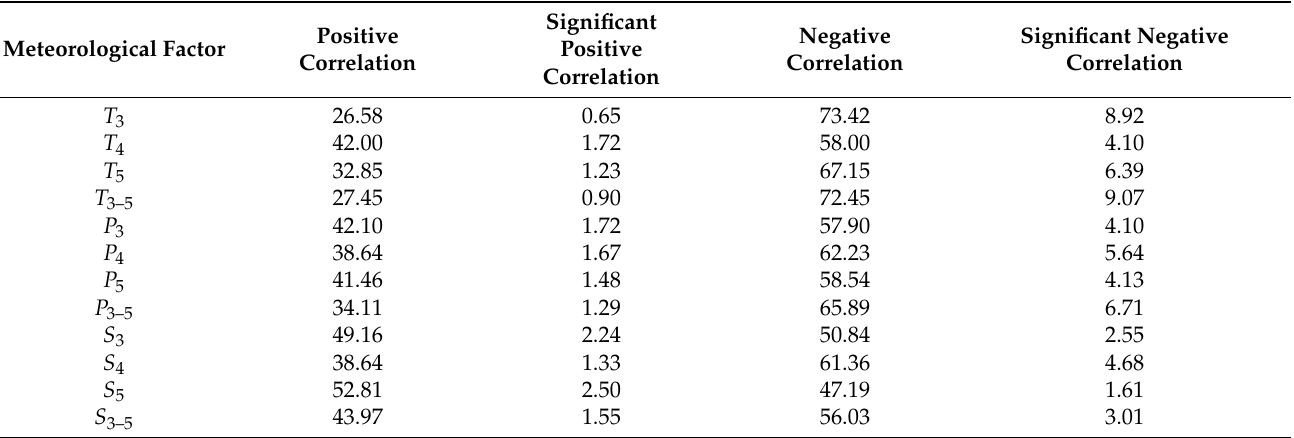
Table 3. Statistics on the correlation between the SOS of the vegetation and meteorological factors in different time periods